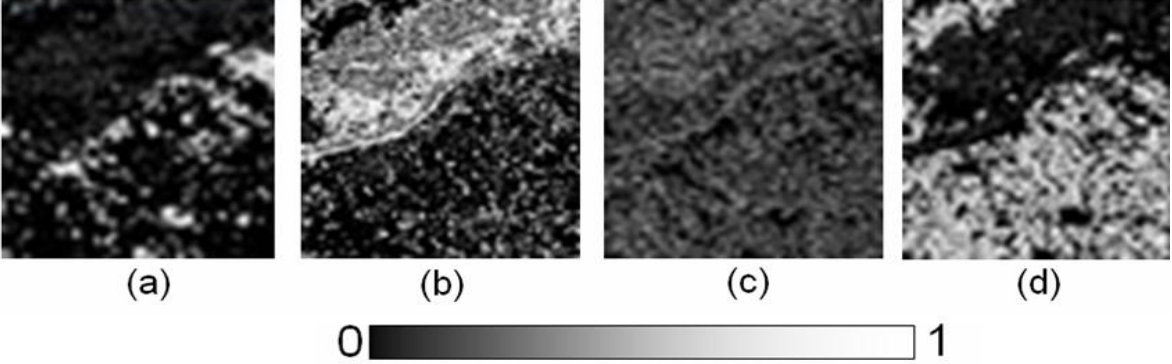
Figure 8. Abundances maps of the four minerals obtained from HMM.